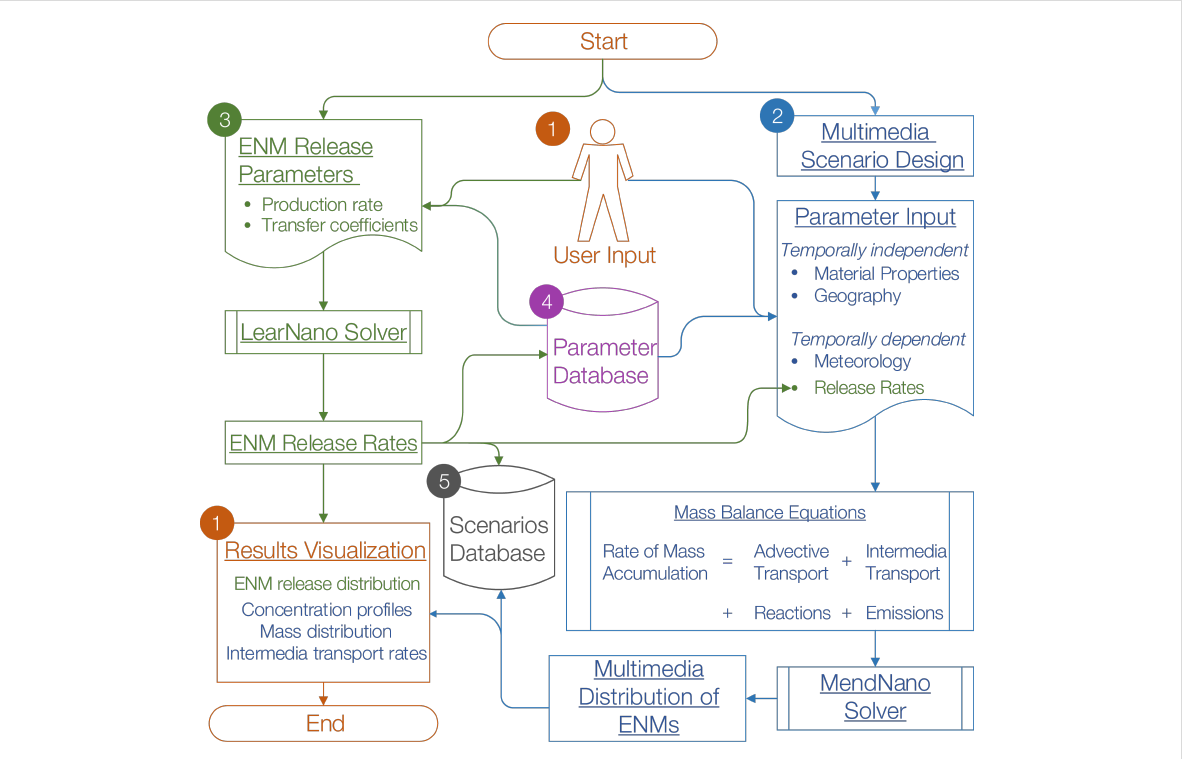
Figure 1: Overview of the release and environmental distribution of nanomaterials (RedNano) simulation tool and its components: (1) GUI, (2) MendNano, (3) LearNano, (4) parameter database, and (5) scenarios